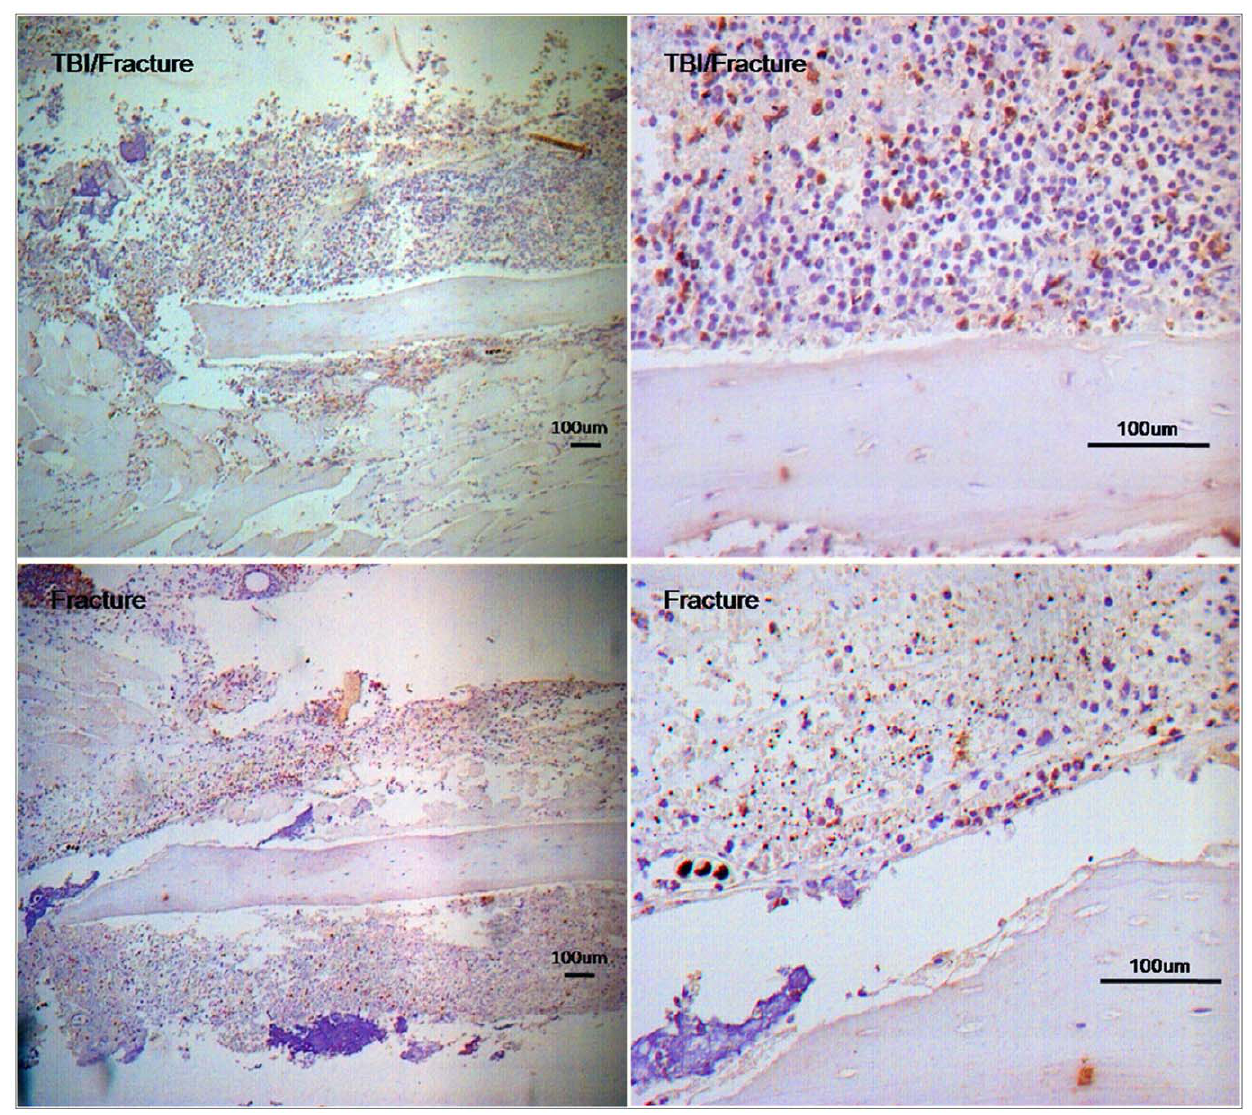
Figure 2. Immunohistochemical staining for SDF-1 in groups TBI/fracture and fracture only on day 2 after surgery. The expression of SDF-1 was observed in both groups. High expression of SDF-1 protein was detected at the surrounding tissue of the damaged bone in the TBI/